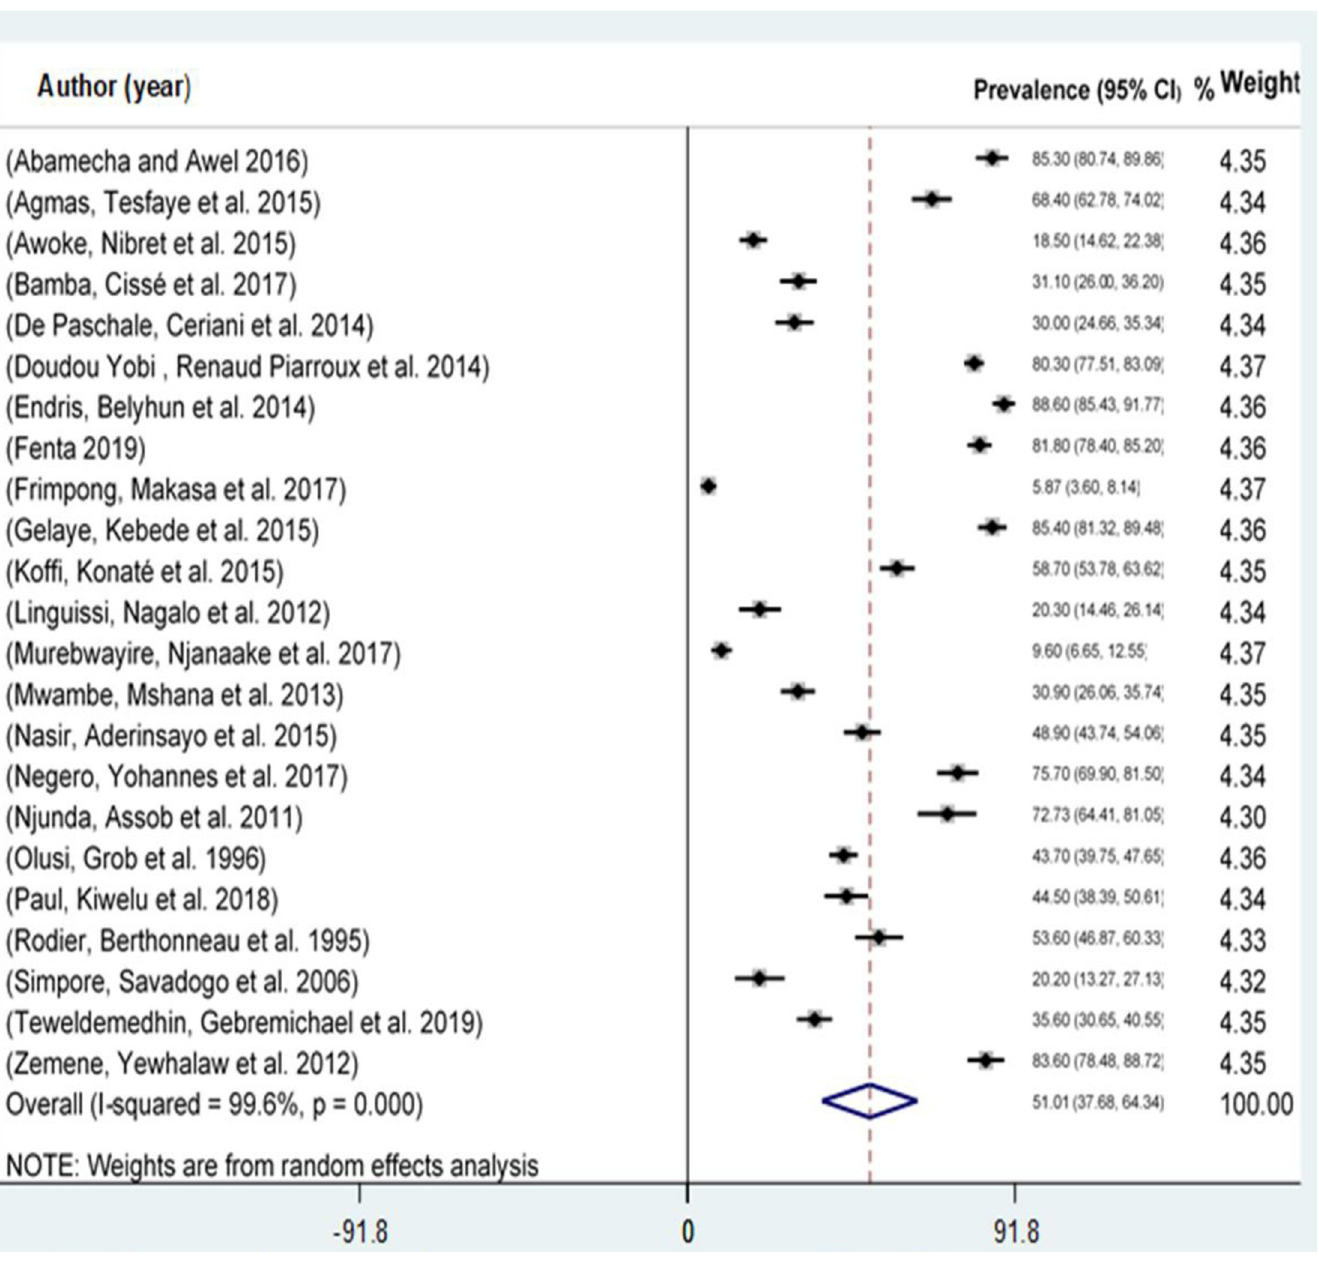
African regions, serological analysis tests, and study design. The analysis done using country showed that the highest prevalence of toxoplasmosis among pregnant women was 80.30% (95% CI: 77.51, 83.09) in the Democratic Republic of Congo, followed by 69.21% (95% CI: 51.94, 86.49) in Ethiopia and the lowest in Zambia, 5.87% (95% CI:3.60, 8.14). However, only a